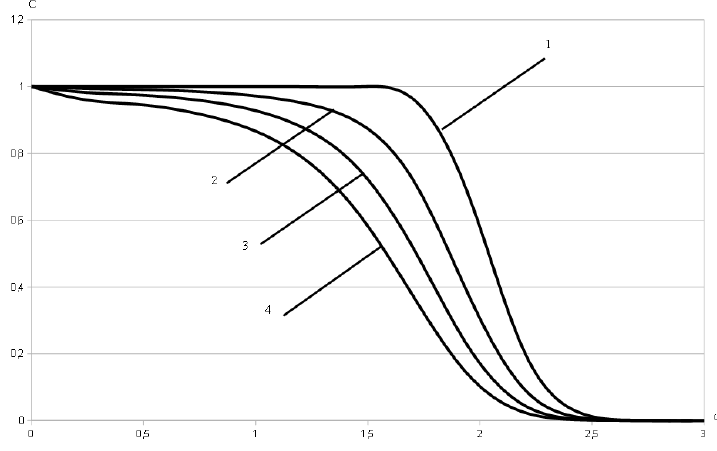
Figure 5. Concentration field along the streamline ψ = 0.5 for t = 5 and a fixed k =